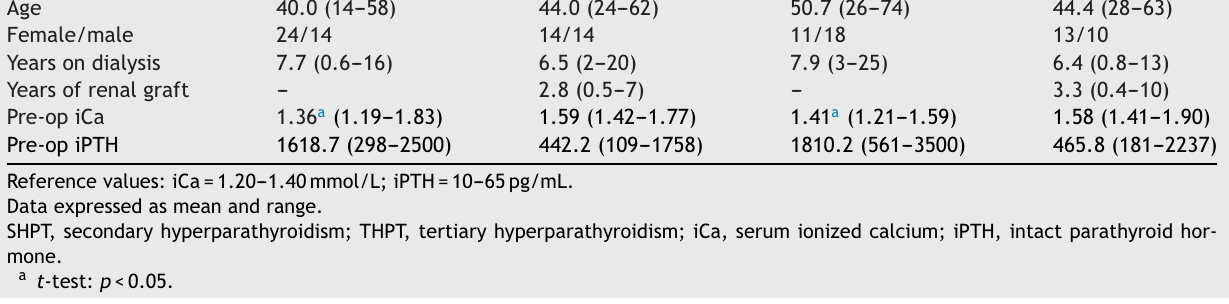
Post-operative mean iCa and iPTH in cured patients in G1-group (conventional).